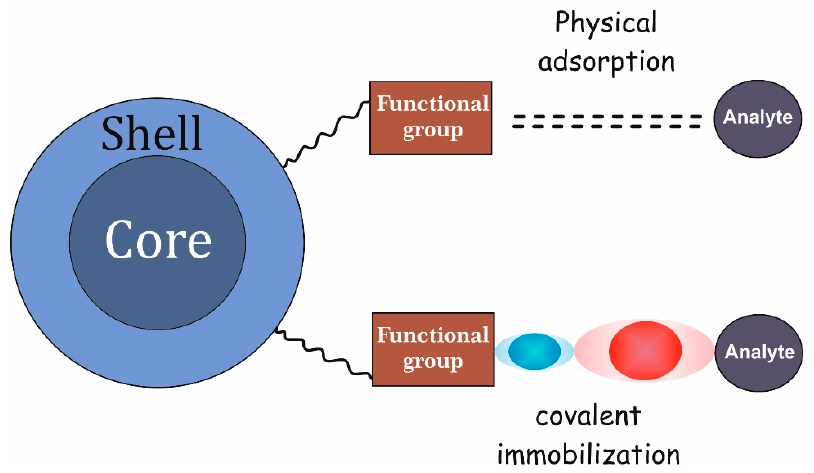
Figure 1. Functionalization of a core-shell type structure of MPs (magnetic particles) [46].